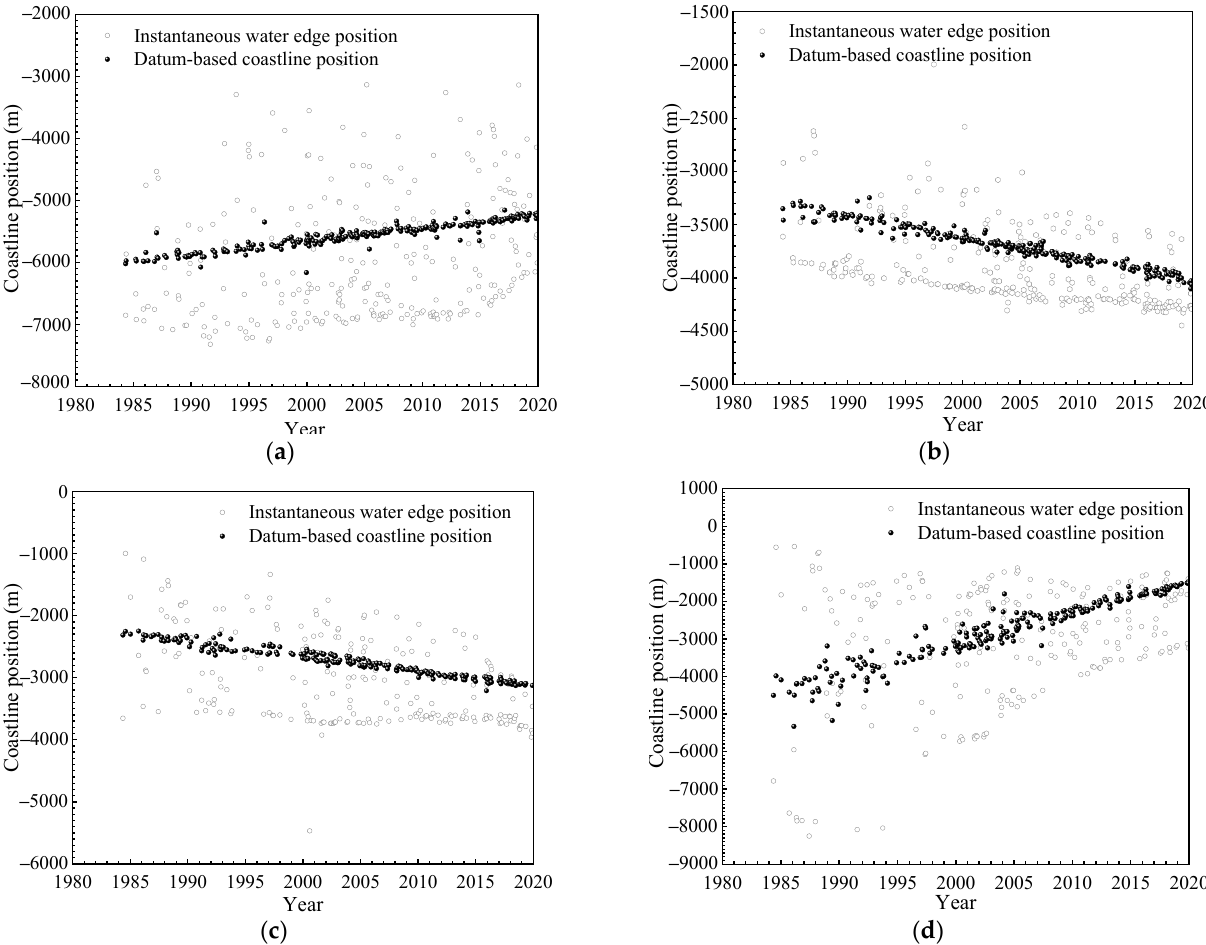
Figure 4. ( a ) The temporal changes of coastline position at the location of transect 81; ( b ) The temporal changes of coastline position at the location of transect 229; ( c ) The temporal changes of coastline position at the location of transect 331; ( d ) The temporal changes of coastline position at the location of transect 431.